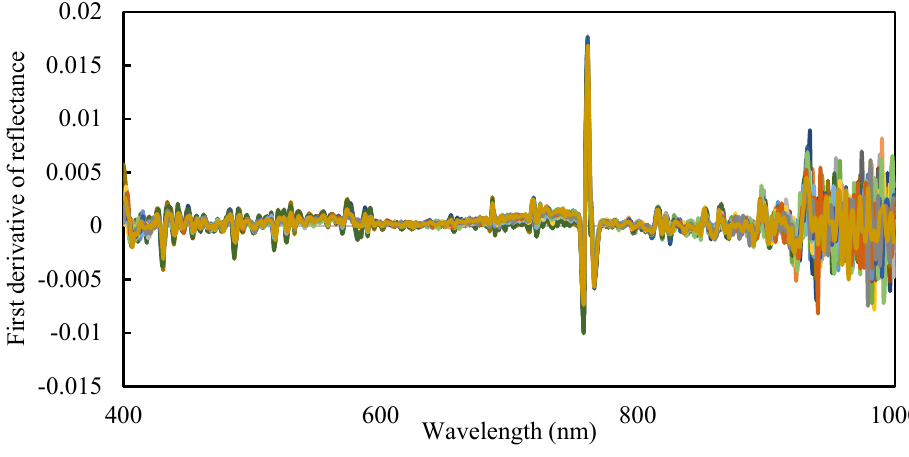
Figure 13. First derivative of reflectance.